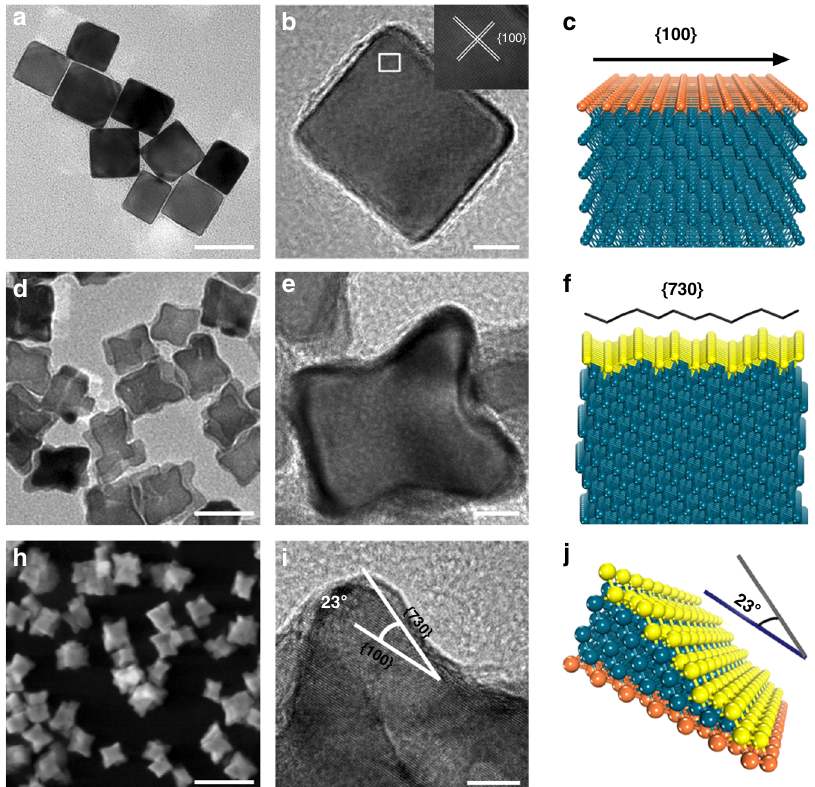
Fig. 1 Characterization of the as-fabricated Pd nanocrystals. a TEM image of Pd nanocubes (Pd NCs) enclosed by {100} surface facets. Scale bar: 50 nm. b TEM image of a single Pd NC. Scale bar: 10 nm. c Atomic con fi guration diagram of Pd NCs. d TEM image of Pd concave nanocubes (Pd CNCs) enclosed by {730} surface facets. Scale bar: 50 nm. e TEM images of a single Pd CNC. Scale bar: 10 nm. f Atomic con fi guration diagram of Pd CNCs. g HAADF-STEM image of